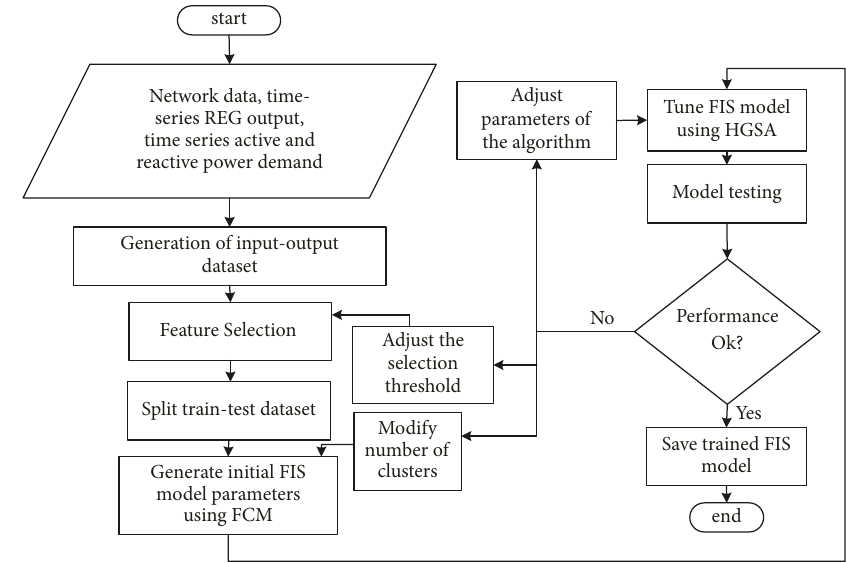
Figure 8: Overall procedure of FIS model training and testing. Table 2: Number and category of selected features. Target